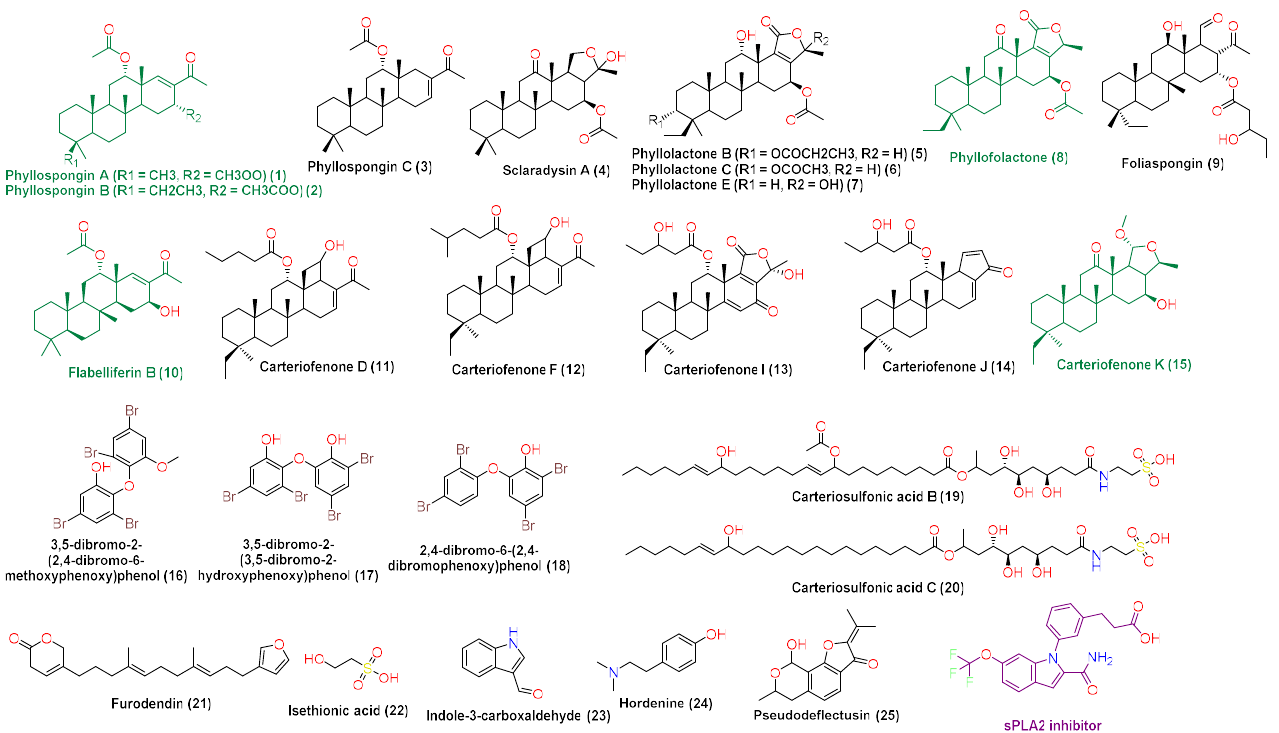
Figure 1. Chemical structures of the compounds 1–25 that were putatively identified in the P. lamellosa -derived extracts. Green-colored compounds were predicted to have anticancer activity and to inhibit sPLA2. The mauve-colored compound is the reported co-crystalized inhibitor of sPLA2.